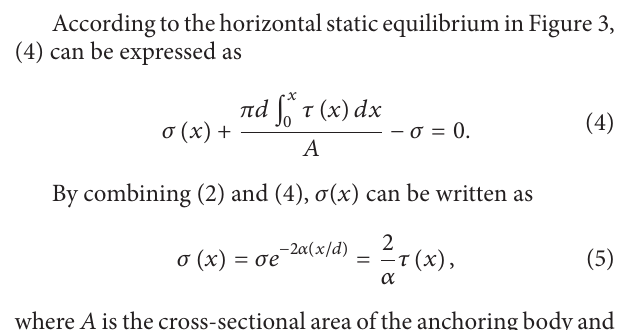
Figure 2: Typical shear stress distribution along a partially damaged interface.